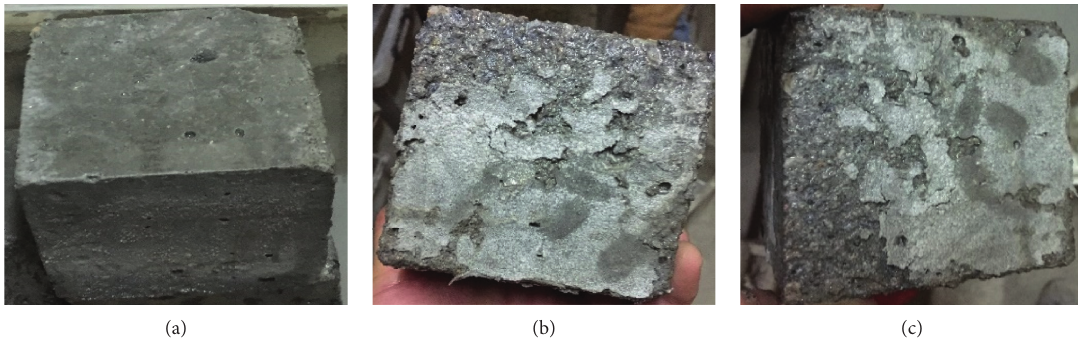
Figure 12: Appearance observation of corroded concrete in tunnel environment. (a) 10 months. (b) 16 months. (c) 20 months.